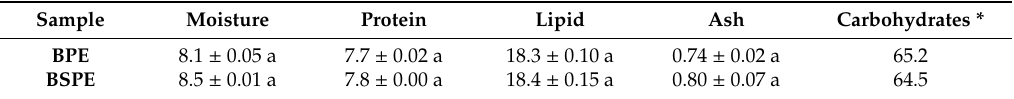
Table 4. Chemical composition of biscuits (g / 100 g